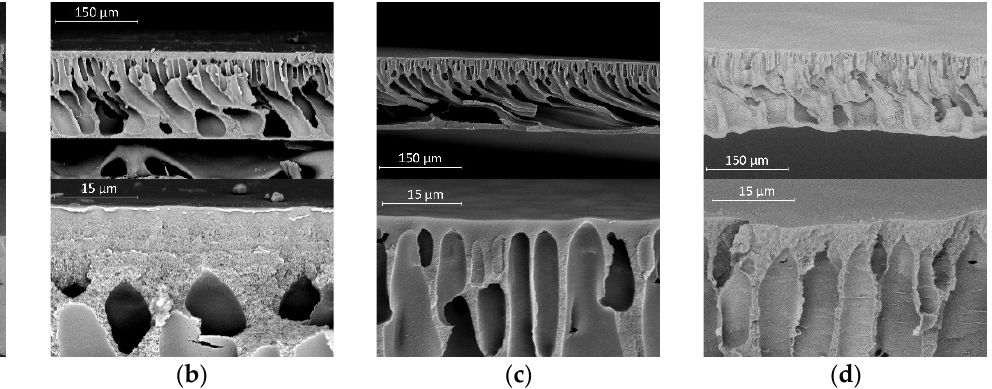
Figure 11. SEM images of the membrane cross-section with respect to the casting solution composi- tion: ( a )—15% PAN with DMSO; ( b )—15% PAN with DMSO/Acetone 50/50; ( c ) 15% PAN with NMP; ( d ) 15% PAN with NMP/Acetone 70/30. The upper row corresponds to lower magnification (image size 550 × 350 μ m); the bottom row—is a selective layer with high magnification (image size 55 × 35 μ m).